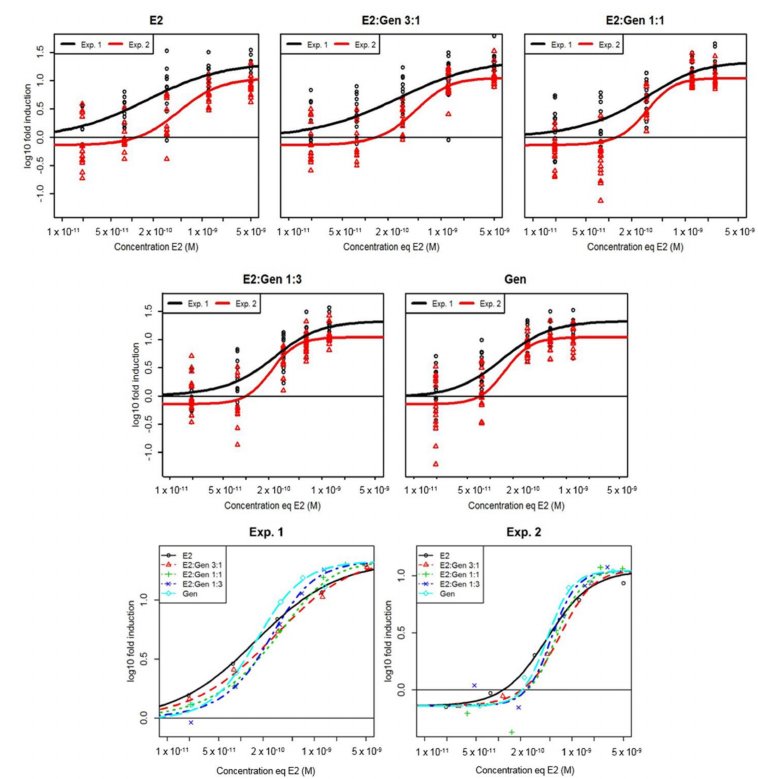
Figure 4. Concentration-response curves of GFP in cyp19a1b -GFP transgenic zebrafish after exposure to estradiol (E2) and genistein (GEN) alone or in combinations (3 different mixture ratios). These data originated from two independent experiments (Exp. 1 and Exp. 2). All the data were modeled by the simple interaction (SA) model. In the first five graphics, each point represents one measure of GFP in one transgenic fish brain ( n = 8–19 fish per condition). In the last two graphics (bottom) which gather all the concentration-response curves, the points represent the means of the GFP experimentally measured for each experiment.